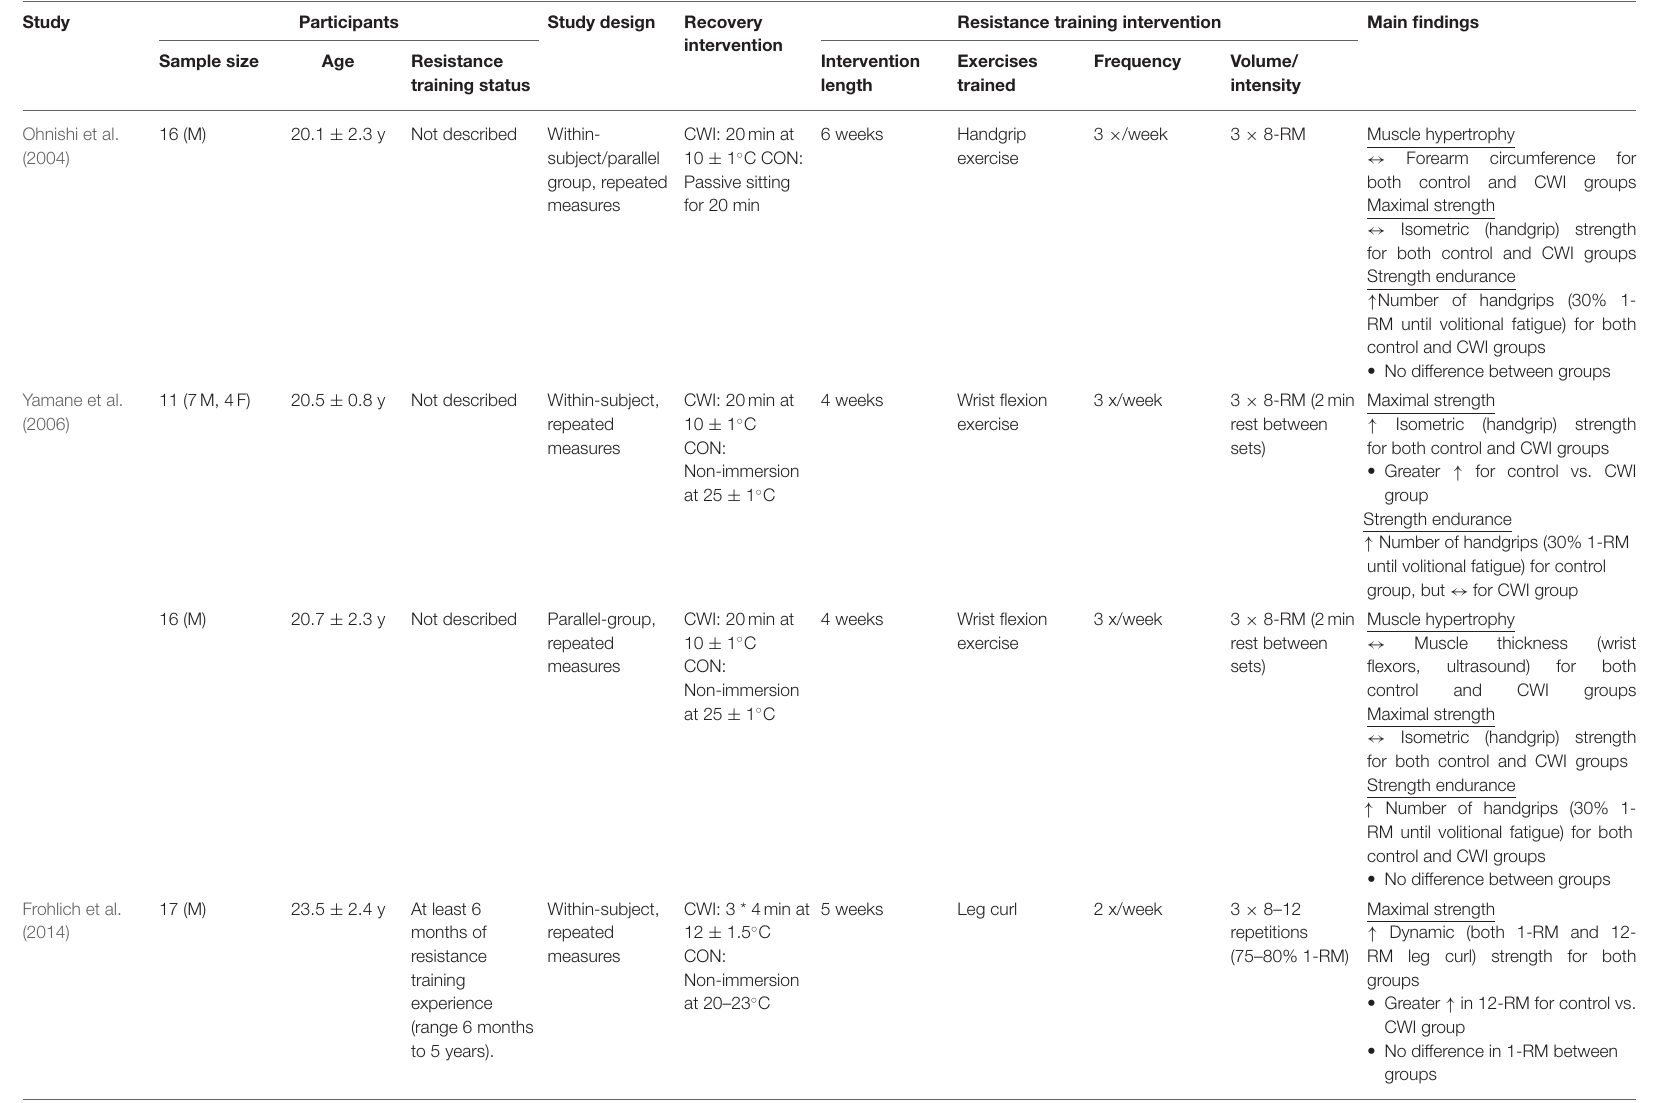
TABLE 1 | Summary of post-exercise cold-water immersion effects on physiological adaptations to resistance